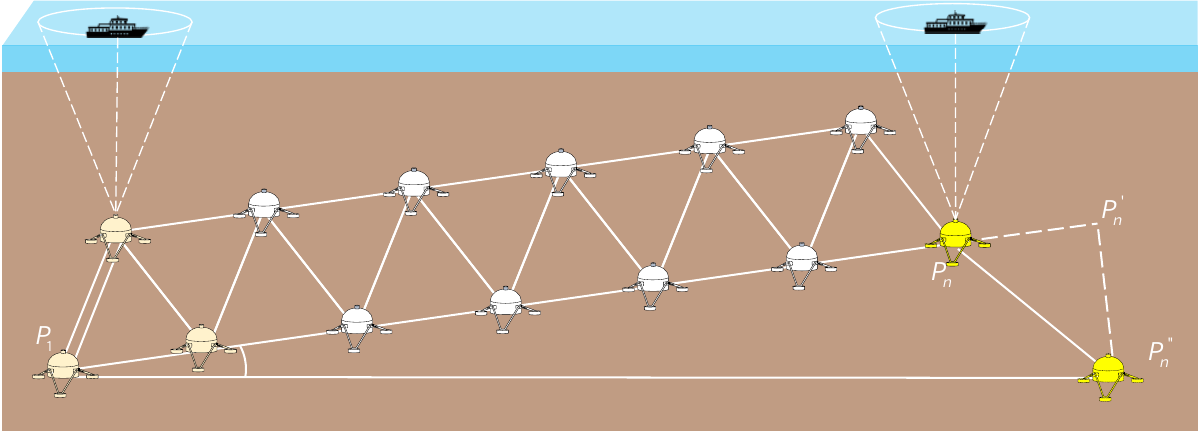
Figure 8. The chain coordinate transfer in the seafloor PNT network composed of the equilateral triangle unit network. The unit network with the yellowish point is the initial network. The white double line represents the starting edge. The golden point is the weakest point.